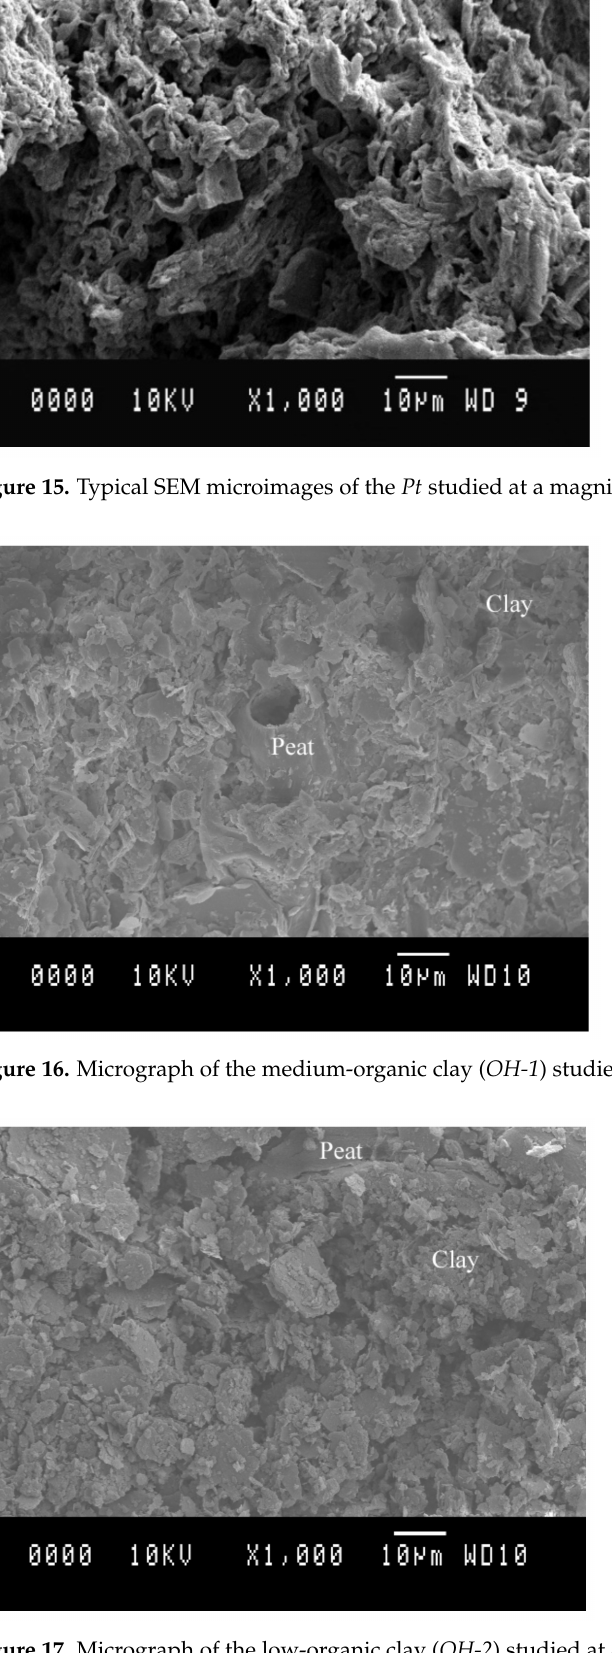
Figure 17. Micrograph of the low-organic clay ( OH-2 ) studied at a magnification of